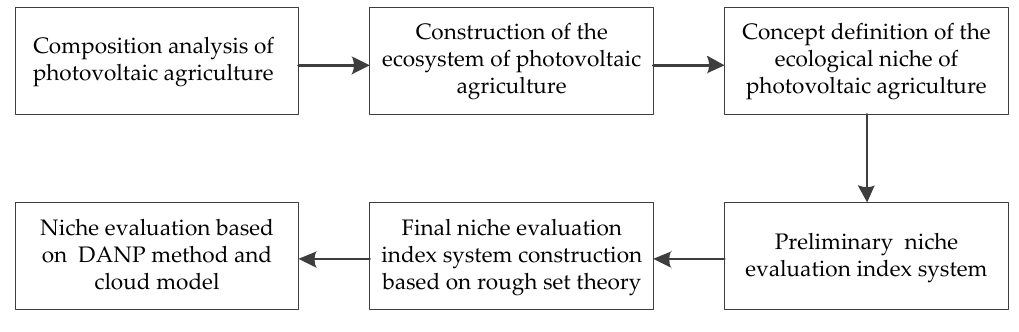
Figure 1. Analytical framework.